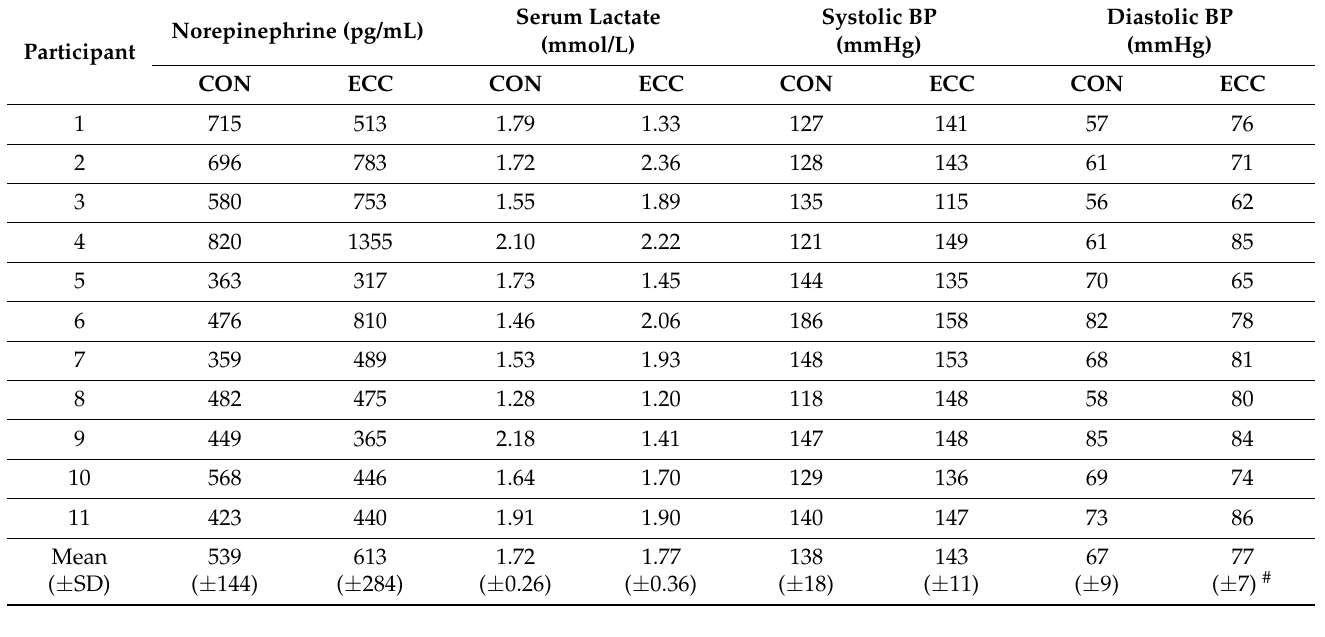
Table 2. Norepinephrine, serum lactate, and systolic and diastolic blood pressure (BP) for all participants measured at elapsed time of 45 min of either concentric (CON) or eccentric (ECC) cycling. Mean ( ± standard deviation, SD) listed. # significantly different from CON.